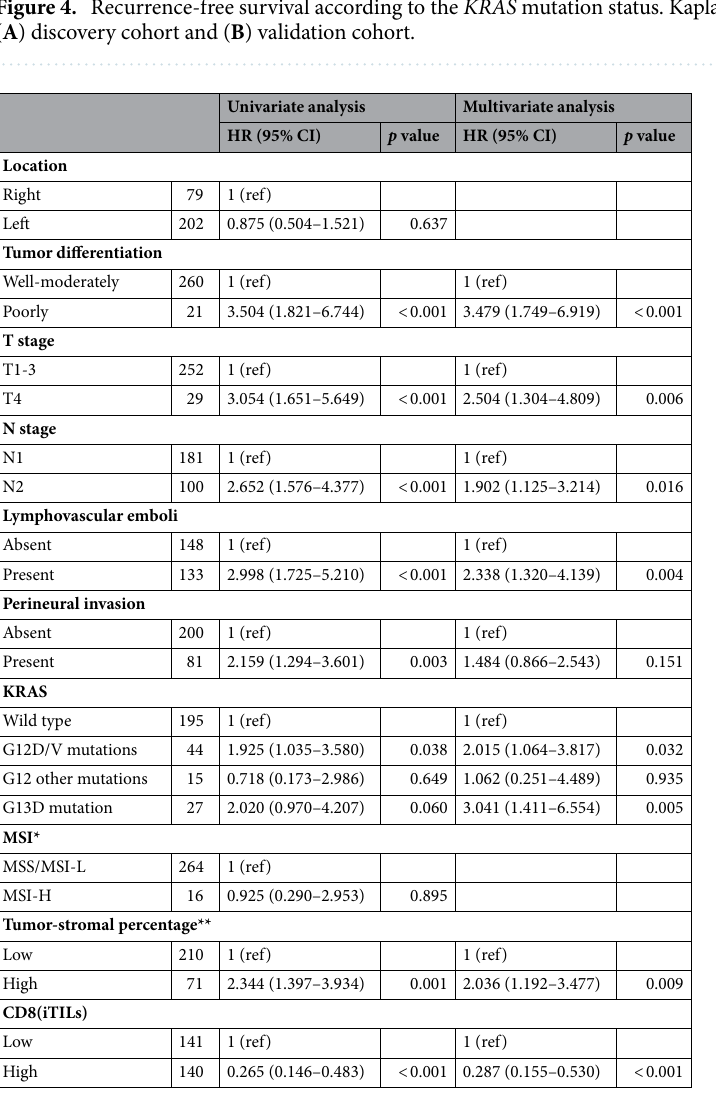
Table 2. Univariate and multivariate analyses in the discovery cohort. *MSI status was not analyzed in one patient. **CRCs were divided into a high group (upper one quartile of the tumor-stromal percentage) and a low group (lower three quartiles of the tumor-stromal percentage). Multivariate analysis was performed without inclusion of the